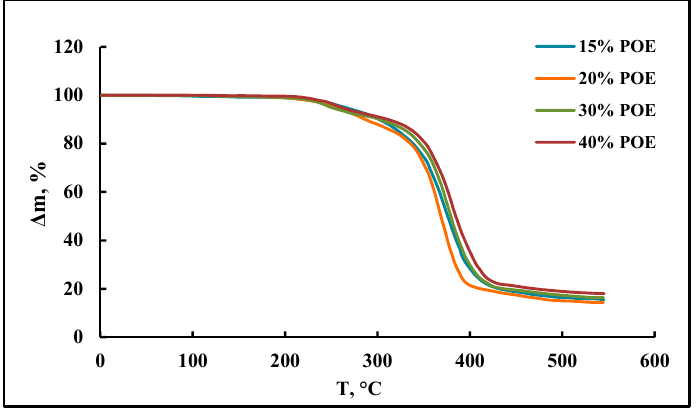
Figure 4. TGA profiles of polymers.